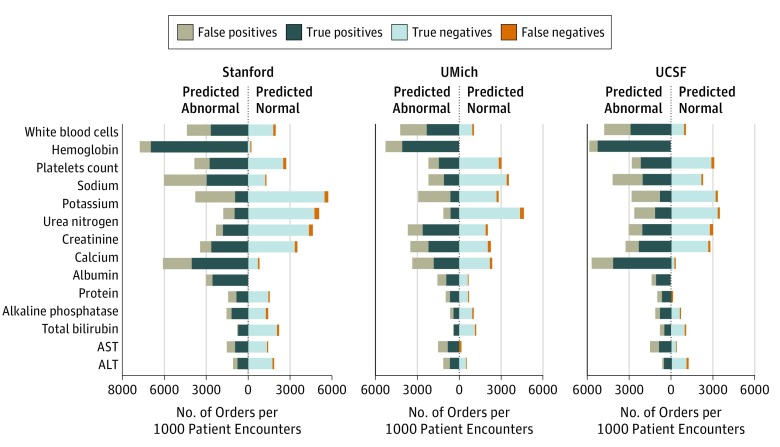
Diagnostic Metrics of Predictions on Common Components in the Data Sets of Stanford University, University of Michigan (UMich), and University of California, San Francisco (UCSF)Fractions of true-negative, false-negative, false-positive, and true-positive results are scaled by the number of orders among each 1000 patient encounters. Predicted normal represents the volume that the model would suggest not to order, and we targeted to limit the fraction of false-negative results to less than 5%. For some laboratory tests (eg, albumin measurement at Stanford University), there were almost zero predicted normal results, which means that a few orders existed in the training set that were unpredictable; thus, the predictor could not confidently achieve a 95% negative predictive value by picking any threshold above 0. The model chose a decision threshold equal to 0, which led to scores of all orders in the test set falling above the decision threshold, thus always encouraging ordering the test. ALT indicates alanine aminotransferase; AST, aspartate aminotransferase.